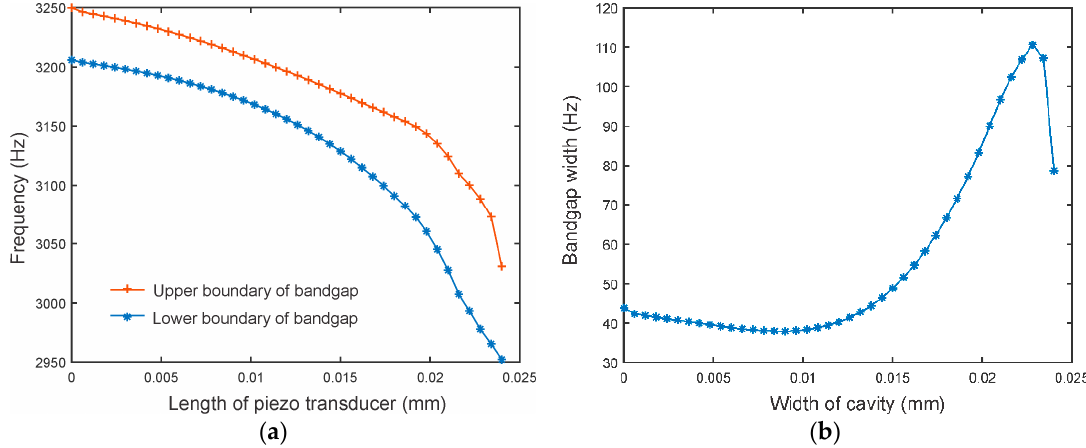
Figure 7. Unit-cell with cavity with height of 2 mm. ( a ) Boundaries of the bandgap; ( b ) Bandgap width.